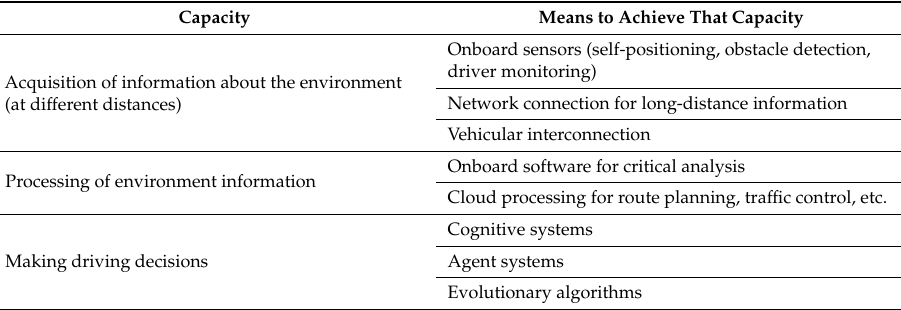
Table 1. Capacities of an IV.